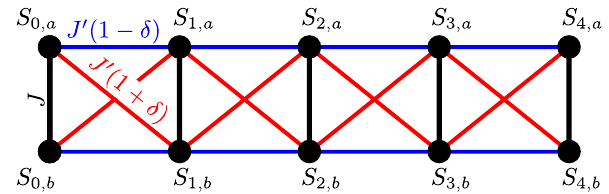
Figure 1: The frustrated spin 1 Heisenberg ladder. The spins are located on the ver- 2 tices. The couplings between different spins are given by J (black coupling), J (cid:48) ( 1 + δ ) (red) and J (cid:48) ( 1 − δ ) (blue). For convenience we refer to one leg of the ladder as leg a , the other leg is b . The fully frustrated limit exhibiting Hilbert space fragmentation is for δ =